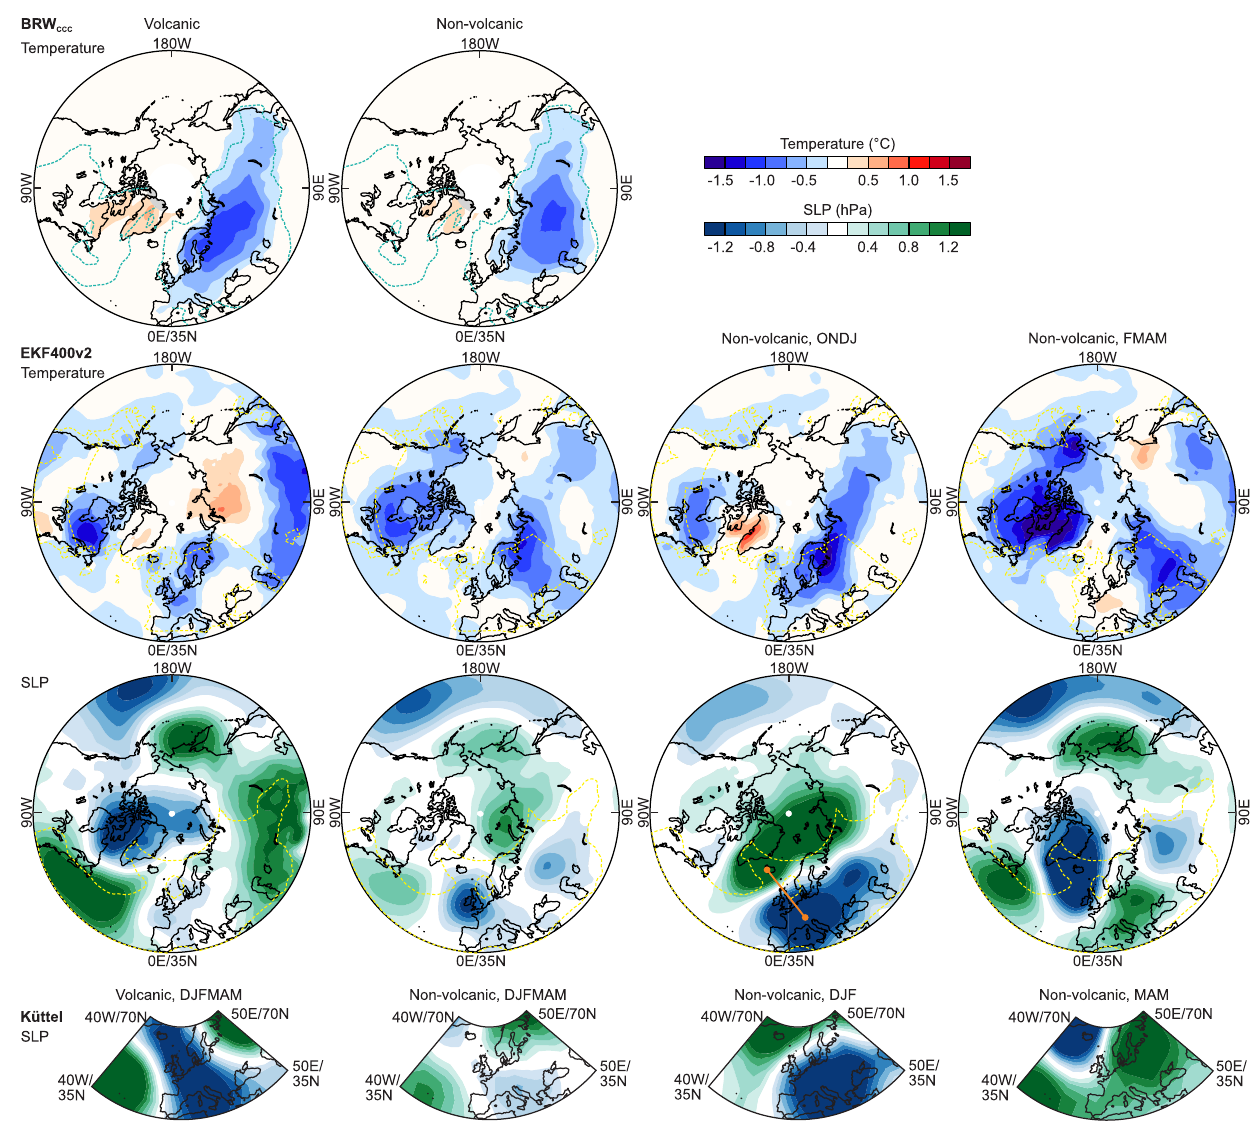
Fig. 3 Volcanic effects and internal variability. Temperature and SLP anomalies (with respect to 1851 – 1900) in (left) the two cold seasons following volcanic eruptions and (second from left) the remaining 6 years of the period in BRW CCC and EKF400v2. For the latter composite, anomalies are also shown for Oct-Jan and Feb-May separately. For SLP we also show composites from Küttel et al. 24 for Dec-May, Dec-Feb, and Mar-May. The green lines indicate a MSESS of 0.2 relative to EKF400 (the yellow dashed line in EKF400 indicates an MSESS of 0.2 relative to HadCRUT5 56 and HadSLP2 57 ). The thick orange line illustrates the index de fi